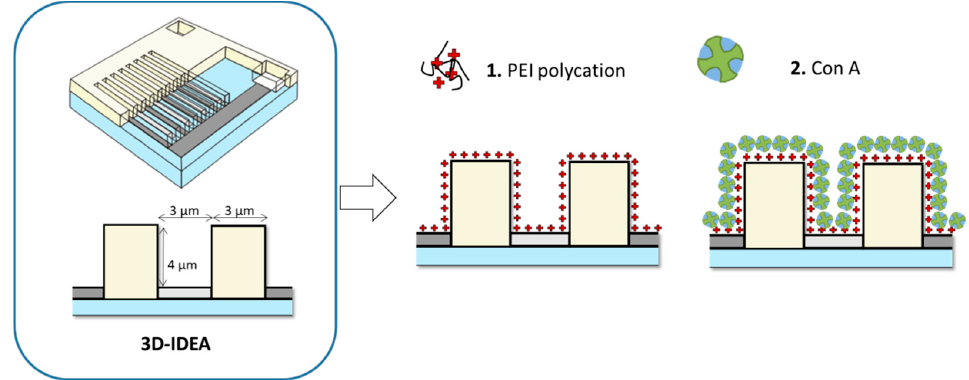
Figure 1. Schematic representation of 3D-IDEA and surface sensor biofunctionalization steps.